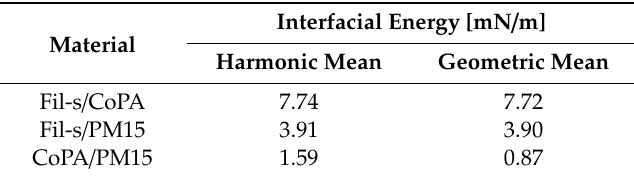
Table 5. Calculated interfacial